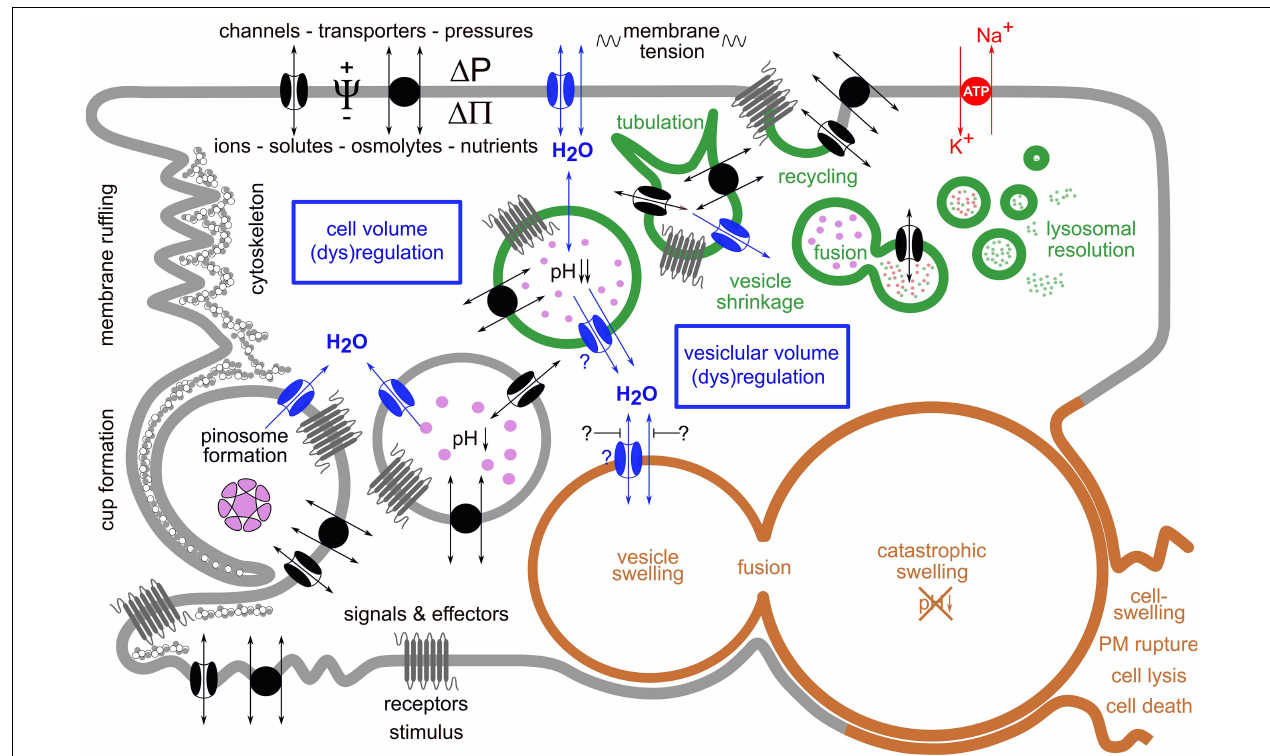
FIGURE 2 | Simplified scheme of key processes in vesicle/vacuole formation and processing during normal macropinocytosis and in methuosis. Macropinocytosis is an actin-driven process that is triggered by various stimuli. It starts with ruffling of the plasma membrane (PM) and formation of a pinocytotic cup, which engulfs extracellular fluid and forms a pinosome by membrane fusion at the tip of a lamellipodium-like structure. Its membrane contains ion channels and transporters, receptors, among other various PM constituents, e.g., phospholipids. The nascent pinosome unselectively engulfs extracellular fluid, along with its ions, nutrients, and metabolites and eventually also toxins or drugs. It may also enclose particulate matter-like exosomes, micro- or nanoparticles, or pathogens such as bacteria and viruses (pink enclosed structure). Under normal conditions (green vesicles), pinosomes move centripetally, become more and more acidic, shrink along their route, and become tubulated, a process necessary for proper sorting and recycling of the vesicles and their cargo. This requires also its decoration with distinct phospholipids and proteins (not shown). Reusable membrane proteins may become inserted again into the PM when vesicles fuse with it. This also recycles incorporated membrane back to the PM and relieves its tension. Vesicles designated for delivery of their contents to lysosomes—for further processing, digestion, or destruction—fuse with them and finally resolve. The resulting products may be further used, e.g., for the cell’s nutrition. To ensure these processes, cell volume regulation and vesicular volume regulation must work hand in hand. This becomes evident from the fact that during pinocytosis, an extracellular fluid volume and membrane area equivalent to the cell’s volume and to the cell’s surface are incorporated within 1 h and 30 min, respectively. The volume regulatory mechanisms involve movement of ions and osmolytes across the PM by means of specific ion channels and transporters. The driving forces for these fluxes are determined by the electrochemical gradients. Water flux is driven mainly by the osmotic ( (cid:49)(cid:53) ) but eventually also by the hydrostatic ( (cid:49) P) pressure differences. The water permeability of the PM is greatly enhanced by water channels (aquaporins, blue). All of these movements are primarily driven by the activity of the Na + /K + -ATPase (red transporter in the PM), an ion pump that moves Na + ions out of and K + ions into the cell, while hydrolyzing ATP as energy source. This process sets up the required ionic and osmotic gradients and determines the electrical potential difference (cid:57) across the PM. The mechanisms for vesicular volume regulation follow the same rules and are in principle identical to those in cell volume regulation, while utilizing their individual set of transporters and channels. In methuosis, a lethal process of aberrant pinocytosis where cells “drink themselves to death,” these processes are severely disturbed (brown vesicles). Fluid uptake by macropinocytosis is enhanced, and instead of shrinking, the vesicles swell, do not acidify, remain non-functional, and do not fuse with lysosomes, but instead they with each